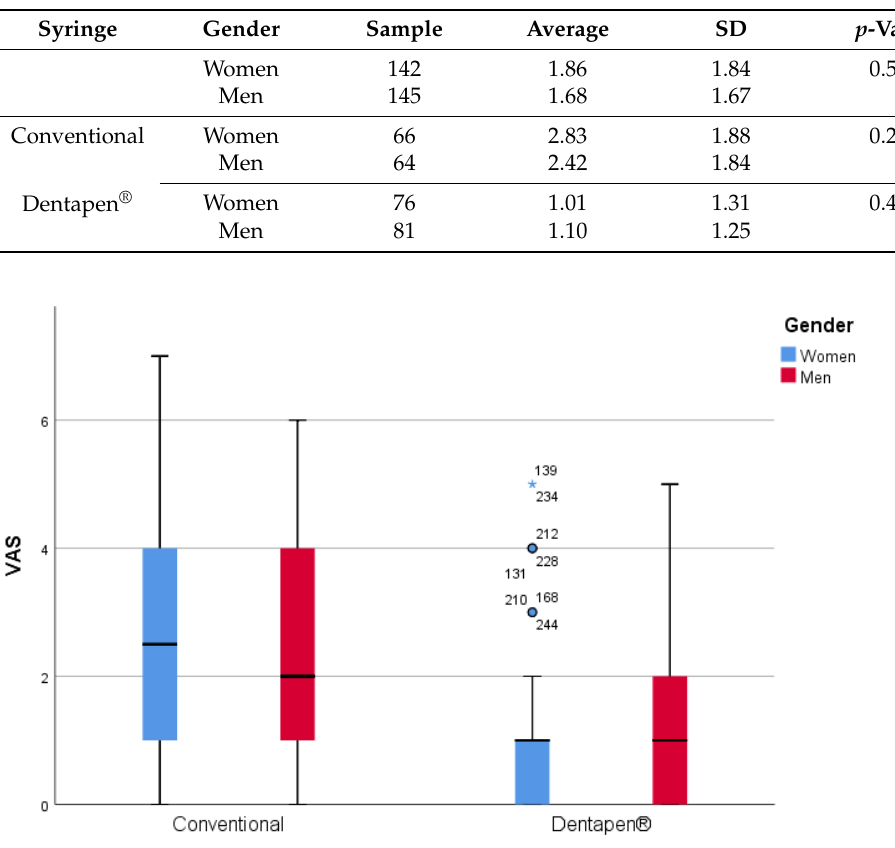
Figure 3. VAS comparison by gender. BOX-PLOT. VAS comparison and statistical significance by